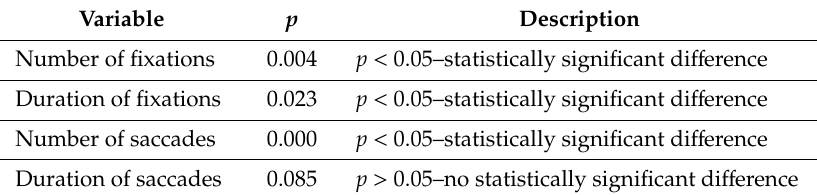
Table 3. T-test results of participants’ eye